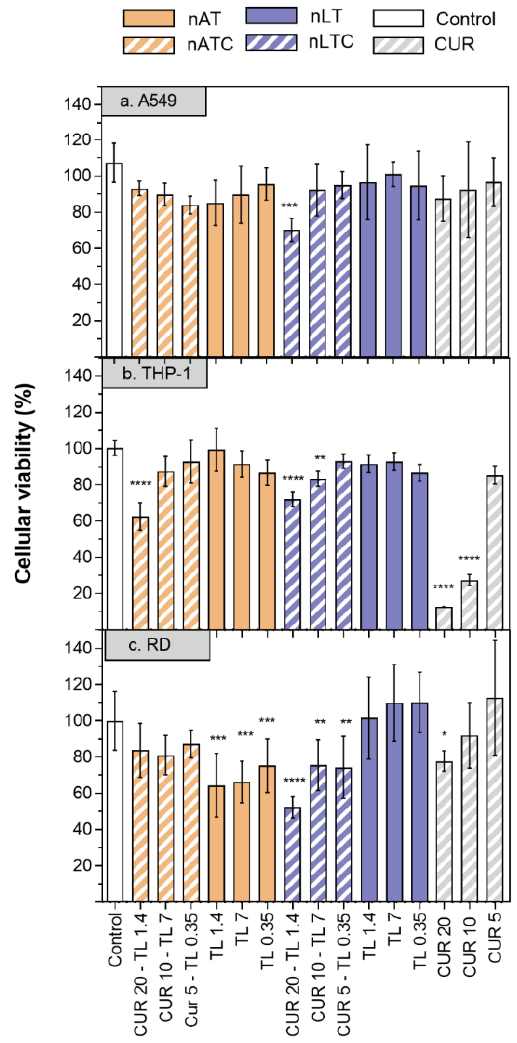
Figure 7. Cell viability of CUR, nATC, nAT, nLTC, and nLT in A549, THP-1 and RD cell lines. (1) CUR 20 µg/mL — total lipids 1.4 mg/mL, (2) CUR 10 µg/mL — total lipids 0.7 mg/mL, (3) CUR 5 µg/mL — total lipids 0.35 mg/mL. Values were analysed using a one-way ANOVA compared with control, * p < 0.05; ** p < 0.01; *** p < 0.001, **** p < 0.0001.